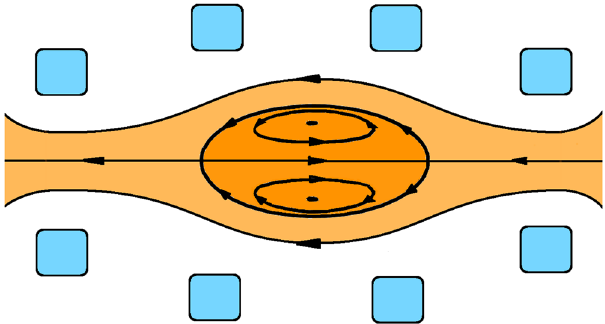
Fig. 1 Schematics of the magnetic fi eld topology in a fi eld reversed con fi guration. Plasma (orange) is contained using a set of axially symmetric magnets (blue). When plasma current is strong enough to reverse the externally imposed magnetic fi eld, a closed fi eld line structure is formed. Closed fi eld lines circle around the so called o-point, where the magnetic fi eld is null. The longest closed magnetic fi eld line enclosing the o-point has null poloidal fl ux and separates the internal closed fi eld region from the open fi eld line scrape-off layer (SOL)